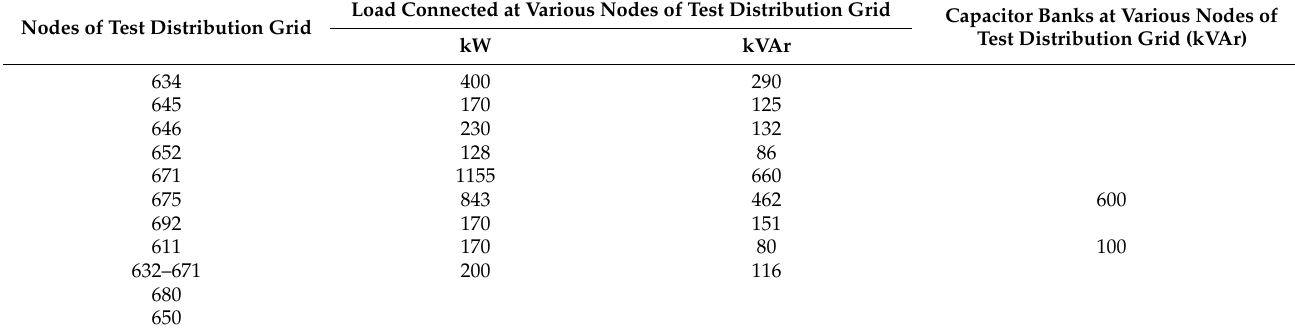
Table 1. Loading status of test system.